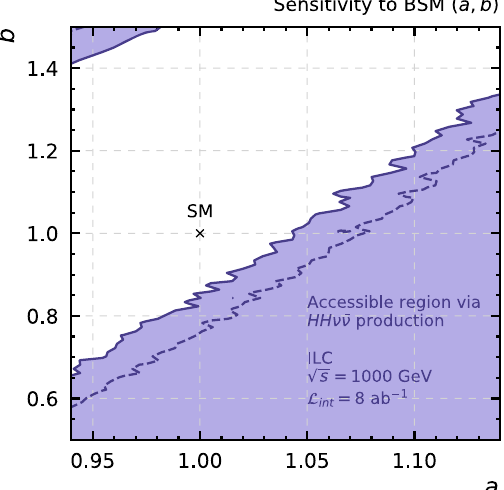
Fig. 29 Accessible region in the ( a , b ) plane to BSM scenarios via e + e − → H H ν ¯ ν → b ¯ bb ¯ b ν ¯ ν events, at the ILC with and L int = 5 ab − 1 (left panel) and at CLIC with